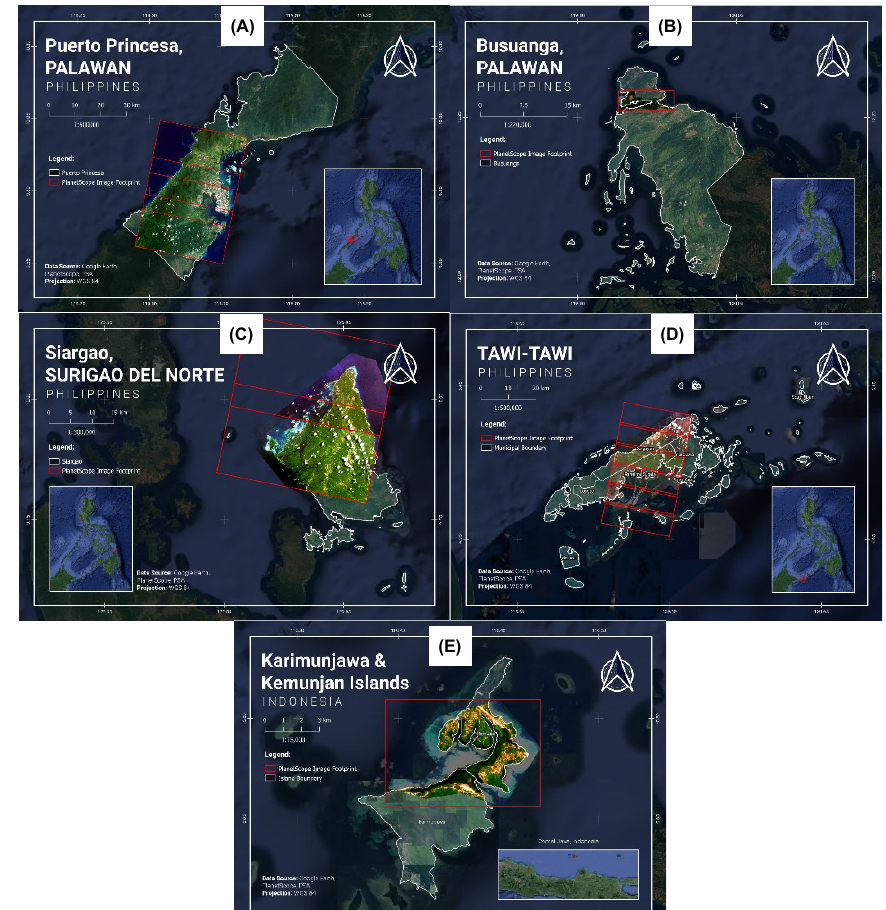
Figure 1. Google Earth maps of selected study areas with PlanetScope true color image and its footprint overlaid. (A) Puerto Princesa City, Palawan, Philippines; (B) Busuanga, Palawan, Philippines; (C) Siargao Island, Surigao del Norte, Philippines;